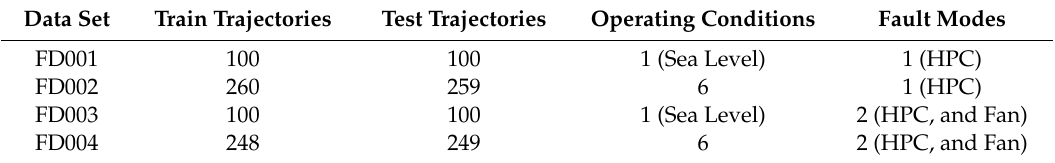
Figure 8. CMAPSS Sensor measurement 11 and remaining useful life (RUL) versus cycle.